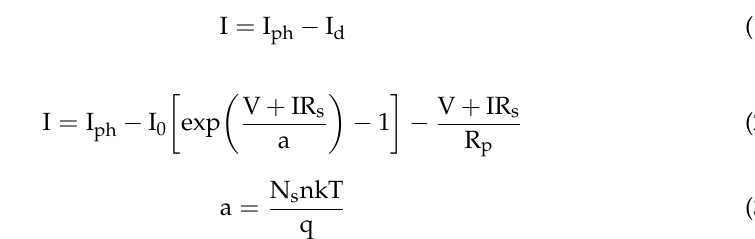
Figure 2. Electrical equivalent circuit model of PV cell.